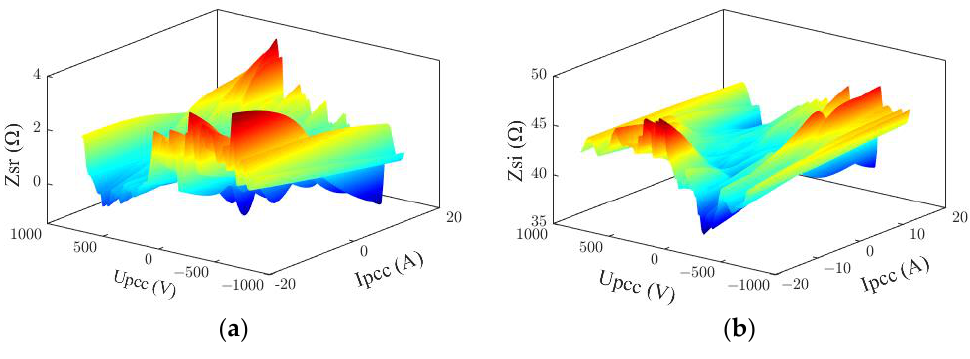
Figure 24. Results of method 4 in 7th harmonic. ( a ) Real part; ( b ) Imaginary part. Figure 23. Results of method 3 in 7th harmonic. ( a ) Real part; ( b ) Imaginary part. Table 11. Evaluation indexes of method 4 in 7th harmonic.